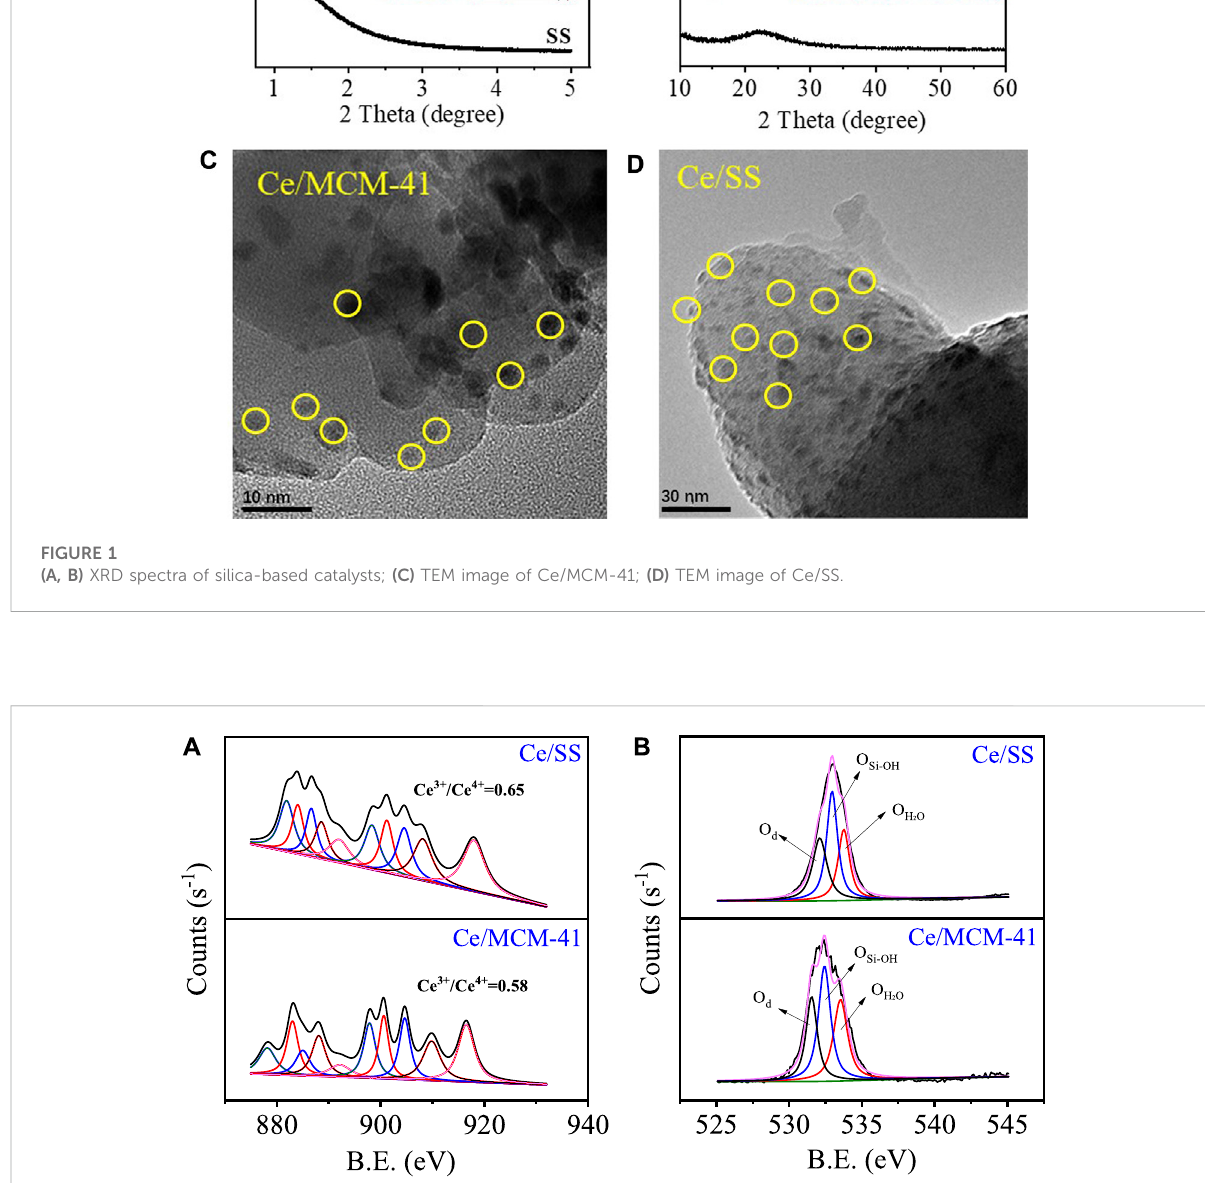
FIGURE 2 High resolution XPS spectra on Ce 3d (A) and O1s (B) for Ce/SS and Ce/MCM-41.